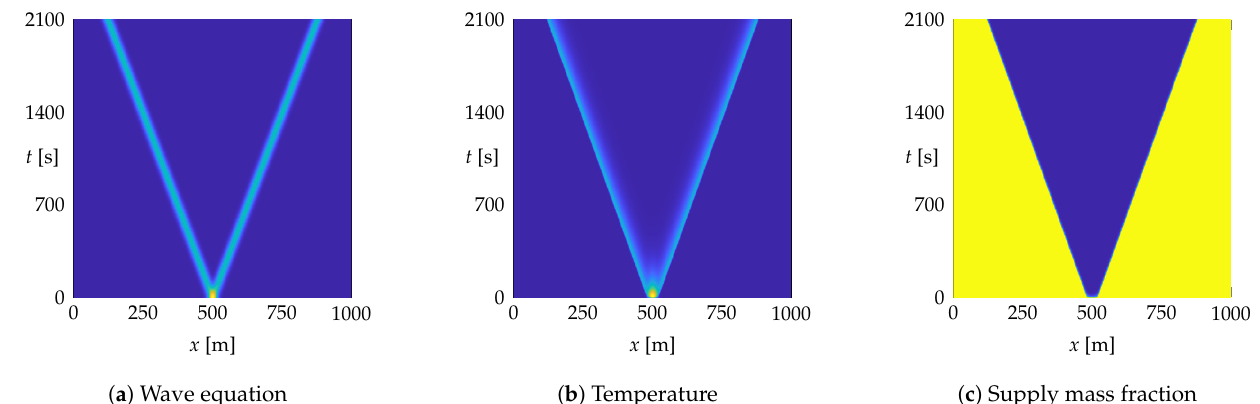
Figure 1. Comparison of (dimensionless) snapshot matrices of a particular solution of the wave equation and a solution (temperature and supply mass fraction) of a wildland fire